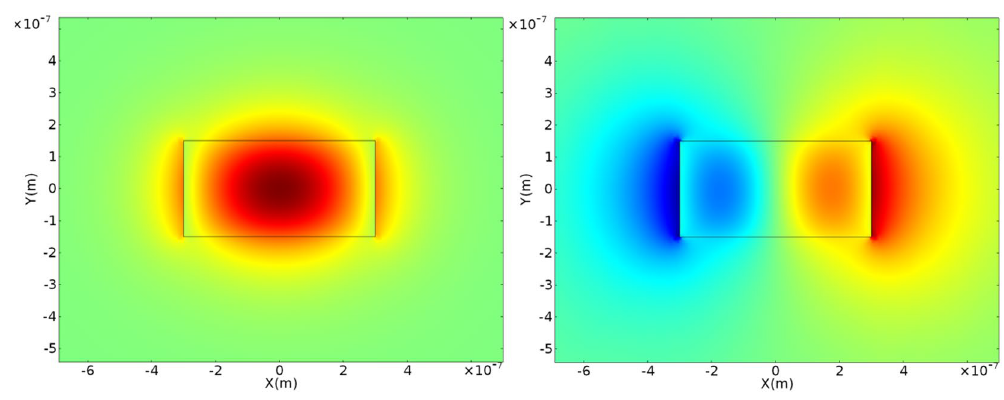
Figure 5. Calculated quasi – TE fundamental mode for the 300 nm × 600 nm waveguide at 1550 nm, and the first order quasi-TE mode at 1310